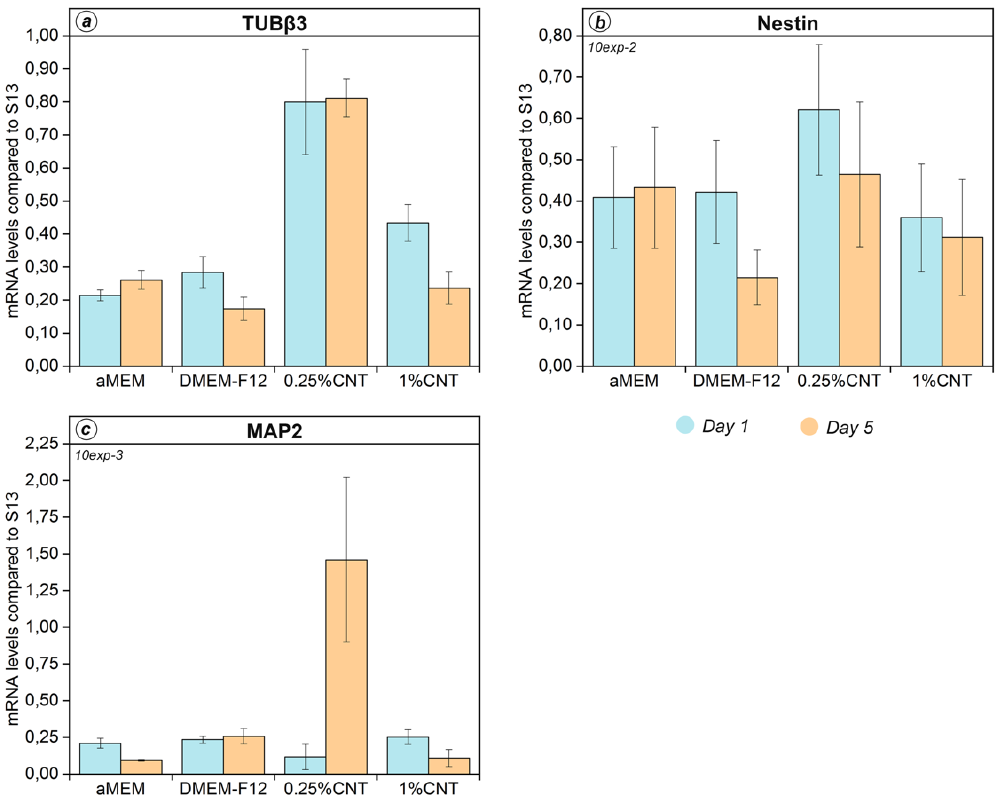
Figure 1. Modulation of ( a ) Tubß3, ( b ) nestin, and ( c ) MAP2 during first five days after differentiation. α MEM: proliferative medium w/o scaffold; DMEM-F12: differentiative medium w/o scaffold; 0.25%CNT: 0.25 wt% p -methoxyphenyl functionalized carbon nanotubes (CNT@PLLA); 1%CNT: 1